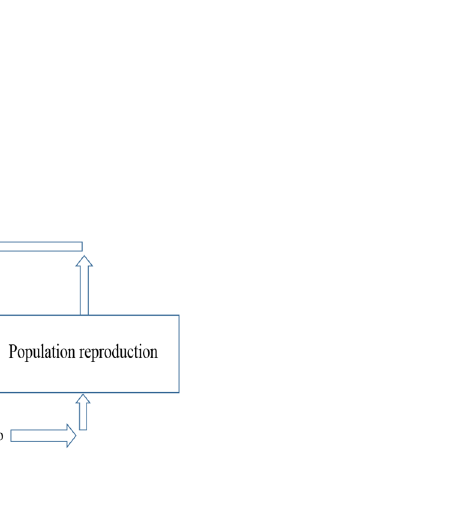
Figure 2. Flowchart of the Genetic Algorithm design